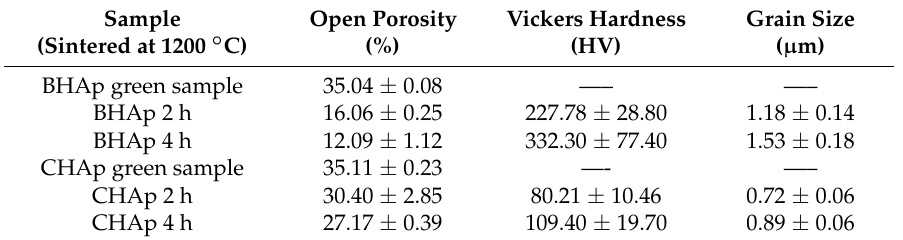
Table 1. Properties of the HAp ceramics from different sources sintered at 1200 °C for 2 h and 4 h.